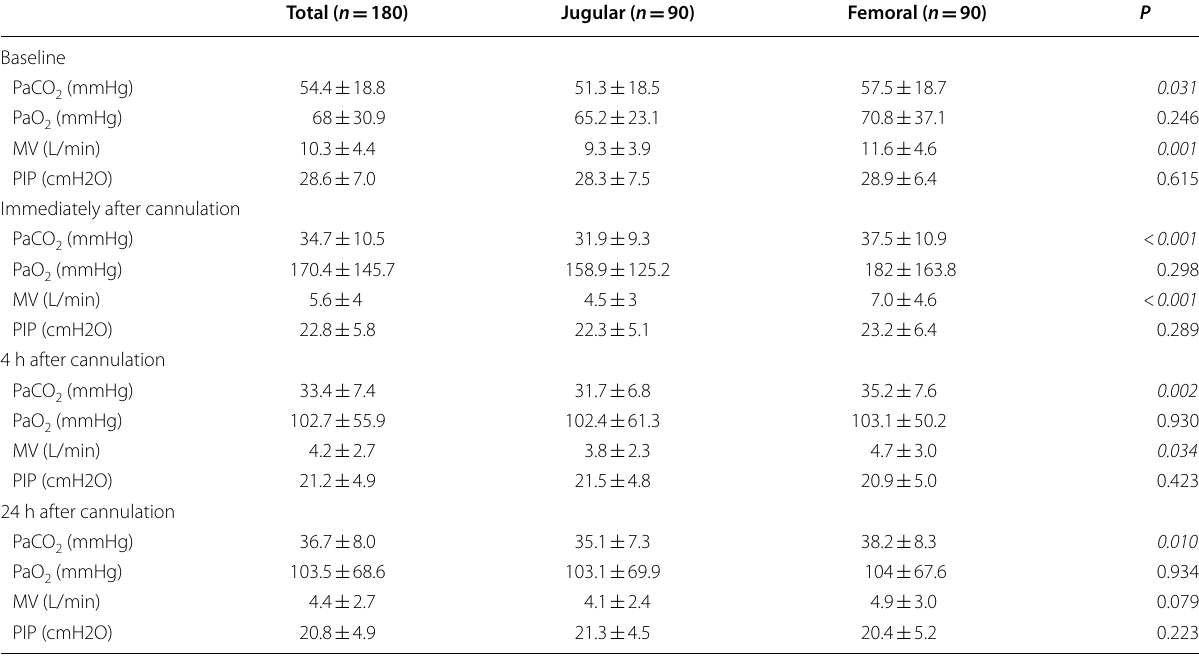
Values are expressed as mean standard deviation; significant P values are in italic ± ECMO extracorporeal membrane oxygenation, PaCO 2 partial pressure of carbon dioxide, PaO 2 partial pressure of oxygen, MV minute ventilation, PIP peak inspiratory pressure